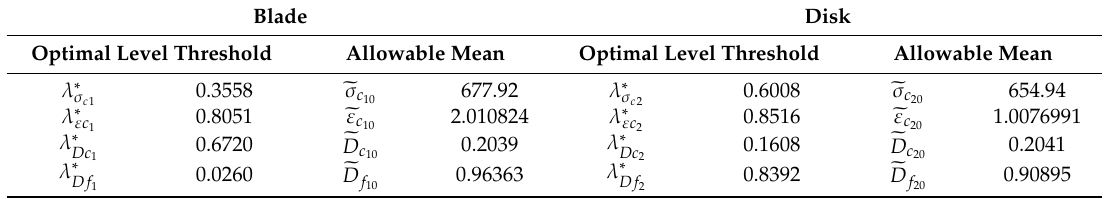
Table 5. Optimized results of a bladed disk. Design Variable